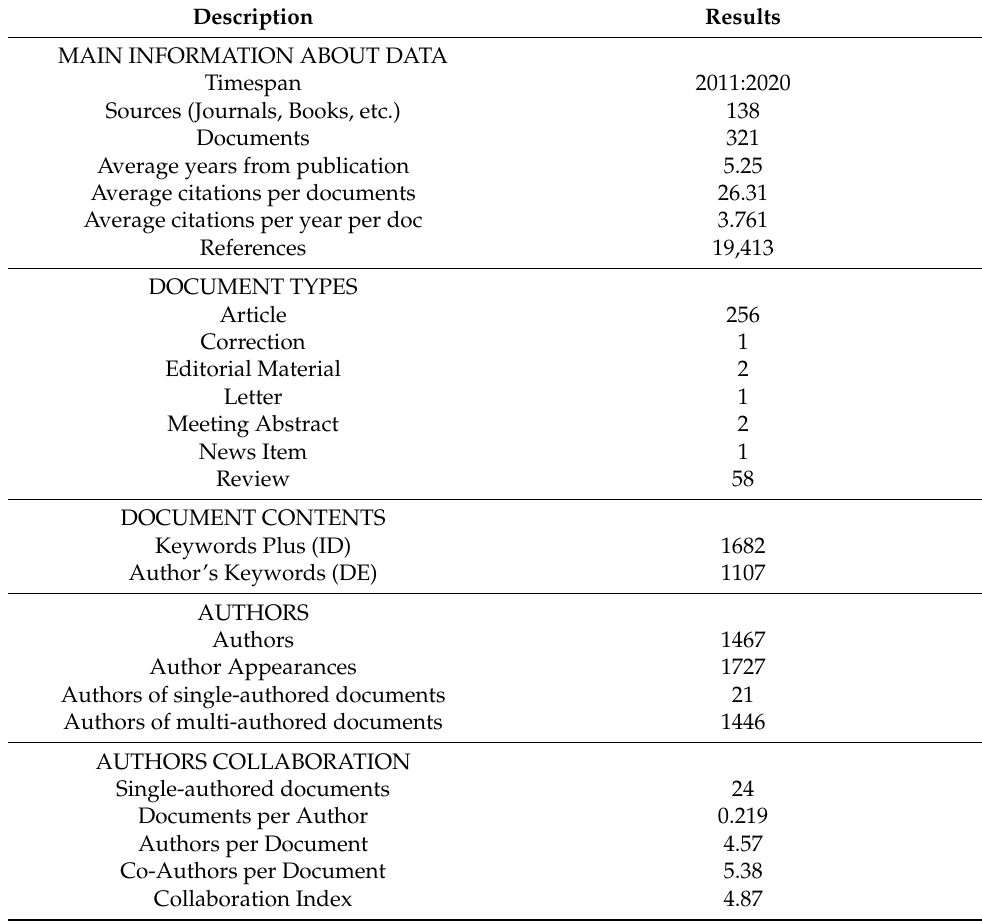
Table 1. Main information of neurotoxicant studies from 2011 to